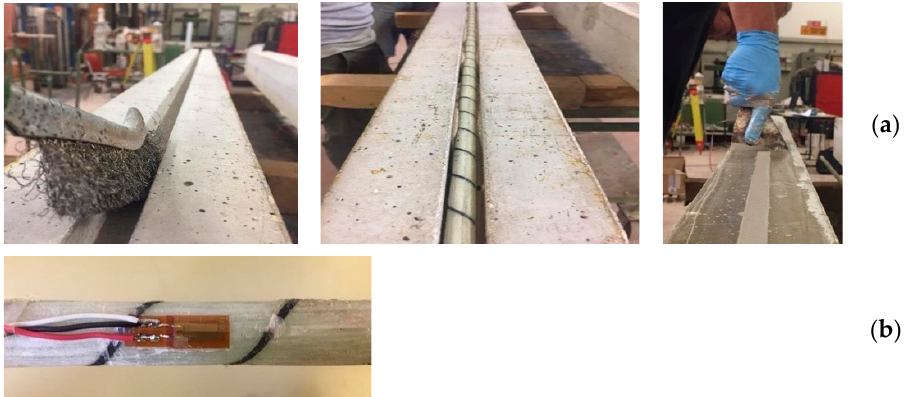
Figure 2. ( a ) Preparation of specimens to test; ( b ) strain gauges on FRP rod. B1 and B2 are the un-strengthened RC beams; B1 GFRP is the RC beam B1 damaged and